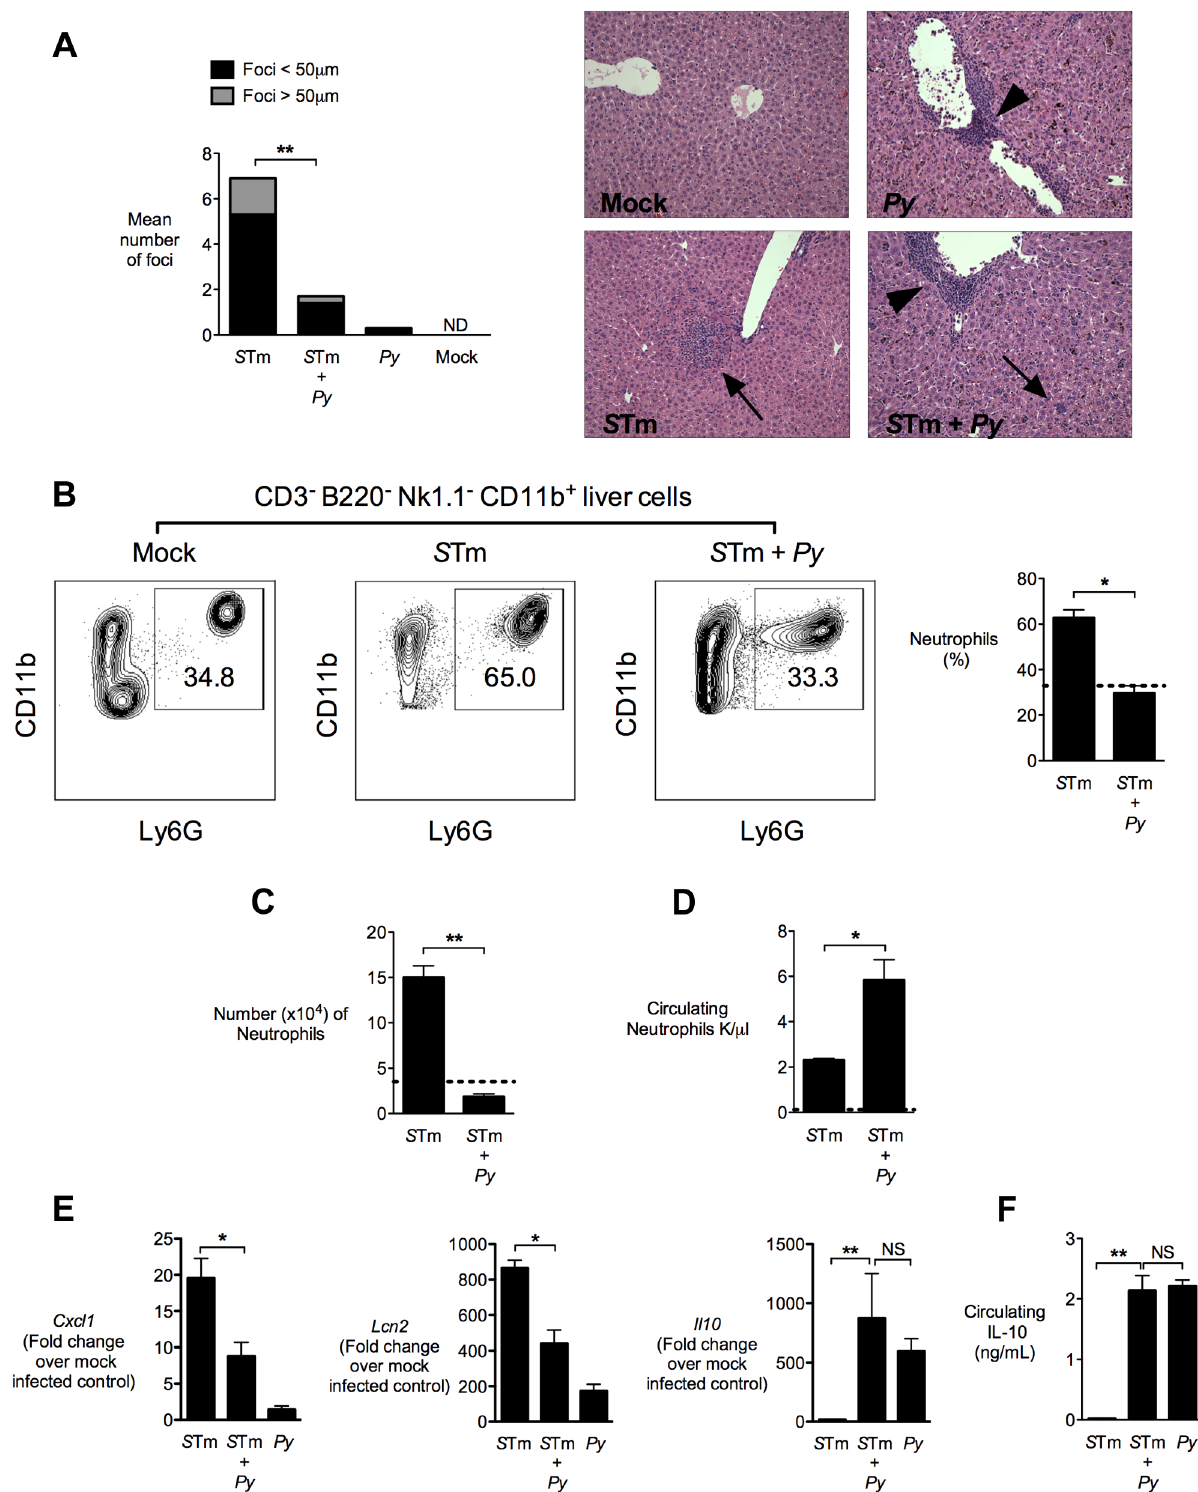
Figure 2. Decreased neutrophil-mediated pathology in the liver of co-infected mice. A, Quantification of inflammatory lesions in the liver and representative micrographs of H&E stained liver tissue from mock-infected mice, mice infected with P. yoelii , or co-infected mice 4 days after IG inoculation of S. Typhimurium in CBA mice (n=5–10). Arrows represent pyogranulomatous lesions and arrowheads represent perivascular monocytic infiltrates. Results are from the experiment shown in figure 1B. B, Representative flow cytometry plots for neutrophil frequency in singlet live CD3 2 B220 2 NK1.1 2 CD11b + liver cells. Right panel shows quantification of neutrophils from S. Typhimurium and co-infected mice (n=4–5). Dotted line represents mock-infected mice (n=2). The gating strategy used for generation of these results is shown in Fig. S2 in Text S1 . C, Number of neutrophils (singlet live CD3 2 B220 2 NK1.1 2 CD11b + Ly6G + ) per 4 6 10 6 liver cells determined by AccuCount beads. Results are from data shown in